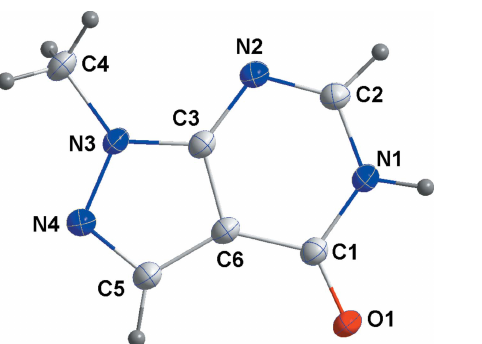
Figure 1 The title molecule with 50% probability ellipsoids.